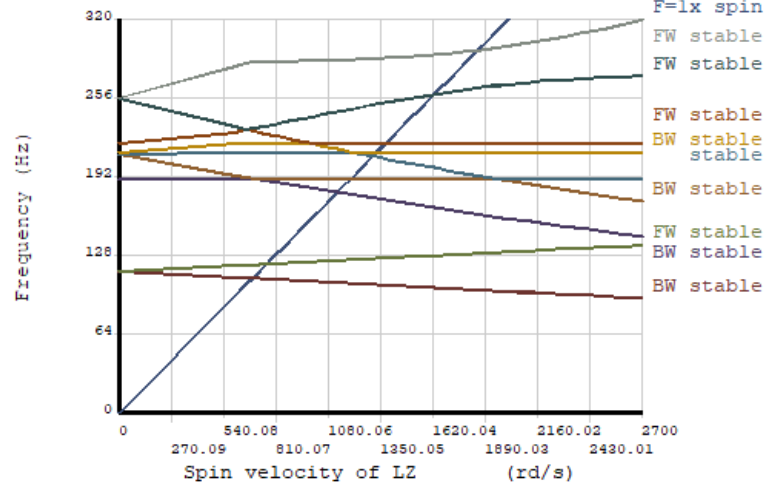
Figure 20. Campbell diagram of the dual-rotor system.